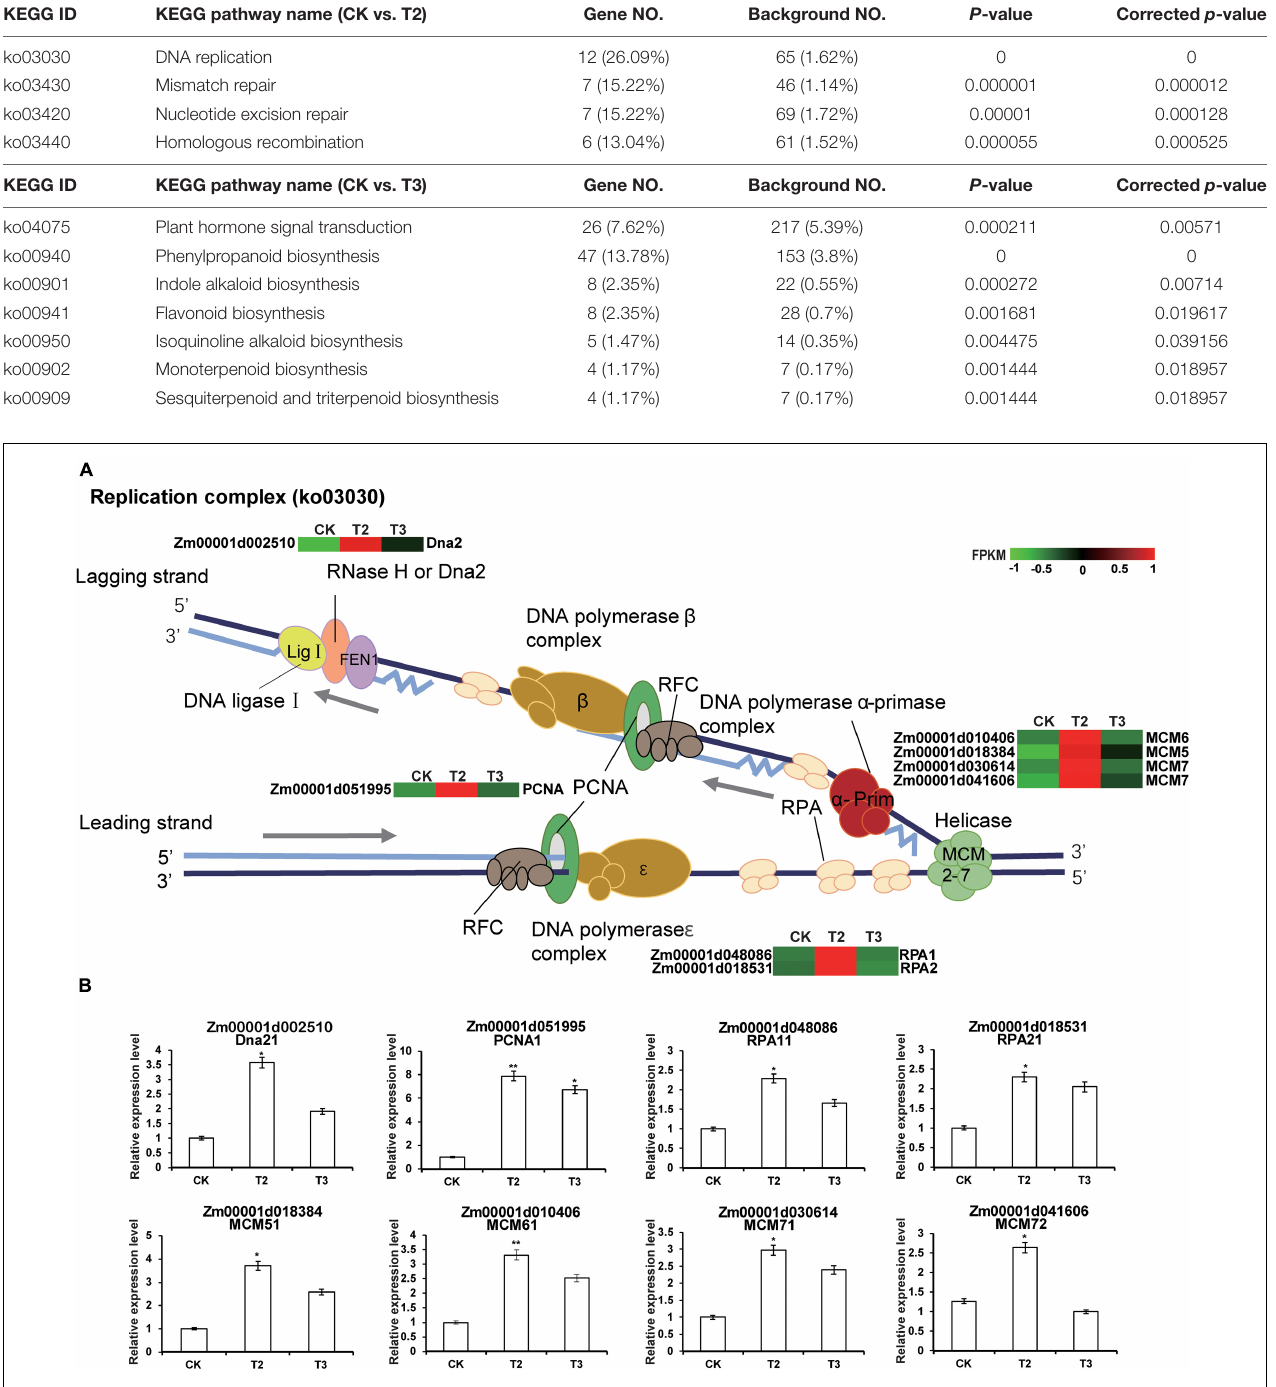
FIGURE 4 | Transcriptional changes of DEGs involved in the DNA replication process in maize seedlings. (A) The heatmap was constructed using the fragment per kilobase of transcript per million mapped reads (FPKM) using online heatmap software (https://www.omicshare.com/tools/Home/Soft/heatmap). For the heatmaps, the transition from green to red represents the expression levels from low to high abundance. (B) DEGs involved in the DNA replication process are verified by real-time quantitative reverse transcription PCR (qRT-PCR). The statistical significance was determined using SPSS 16.0 with a one-way analysis of Tukey’s test. * represents p ≤ 0.05; ** represents p ≤ 0.01. The x-axis represents Se application treatments (CK, T2, and T3), and the y-axis indicates the relative expression levels. Error bar shows the SEs of three biological replicates.